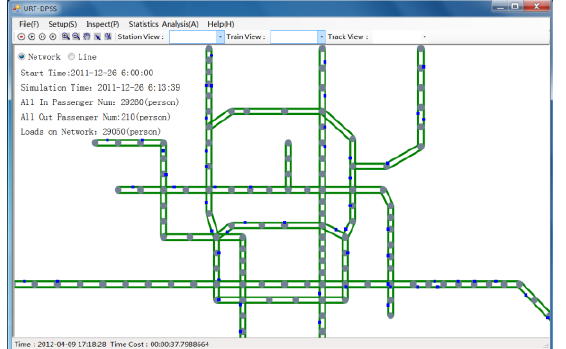
Figure 3. Screen shot of URT-DPSS